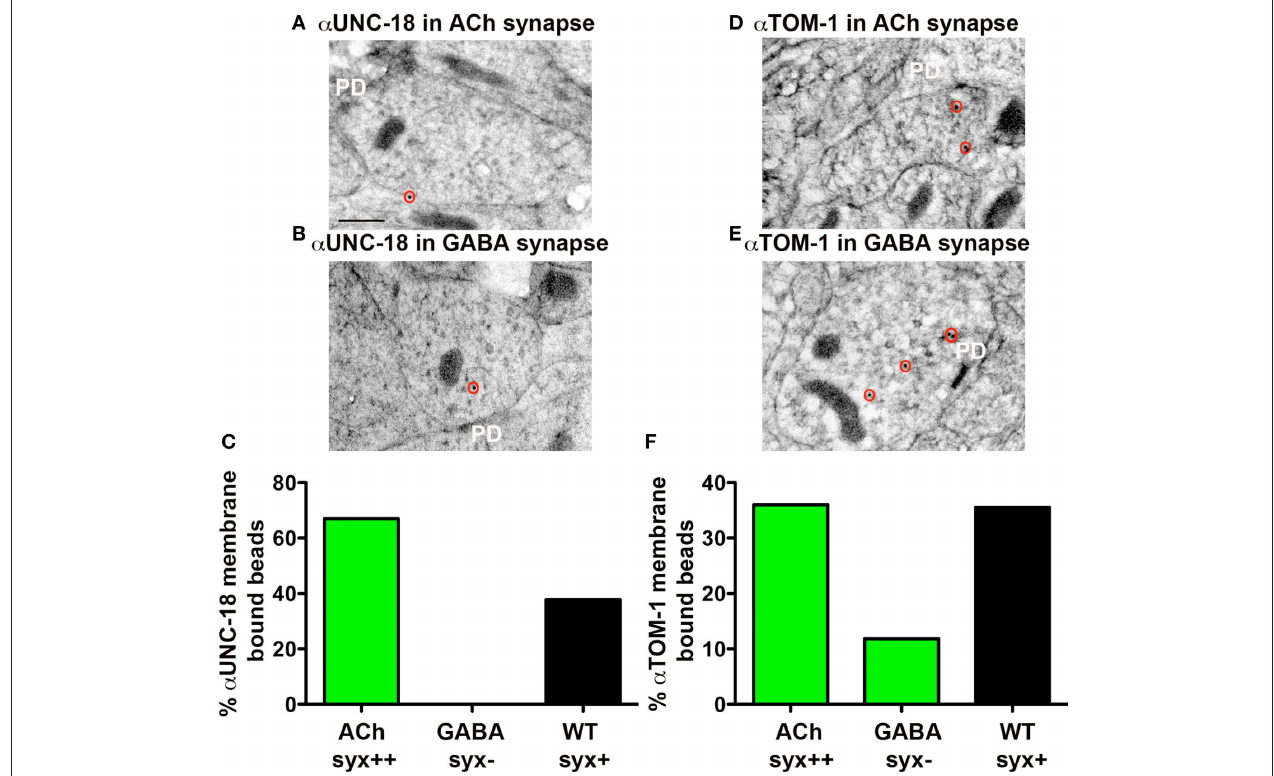
FigUre 2 | Plasma membrane-association of UNC-18 and TOM-1 is dependent on syntaxin. Representative micrographs prepared for immunoEM, showing immunogold labeling of UNC-18 (A,B) and TOM-1 (D,e) in cholinergic syntaxin-expressing NMJs (upper micrographs) and GABAergic syntaxin null NMJs (lower micrographs) from syntaxin mosaic worms (strain EG3278). Immunogold particles are circled. PD indicates the presynaptic density. Scale bar 200 nm. (C,F) The percentage of total synaptic beads that are associated with the plasma membrane ( > 30 nm) in cholinergic (syntaxin ++ ) and